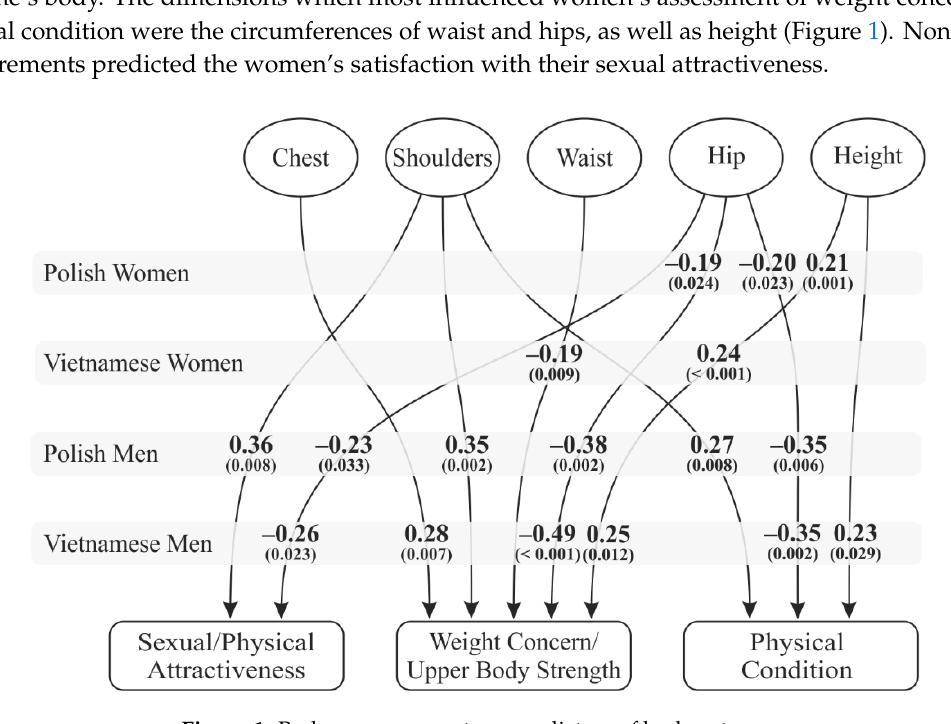
Table 2. Cross ‐ cultural and gender differences of body esteem and perceived stigmatization.